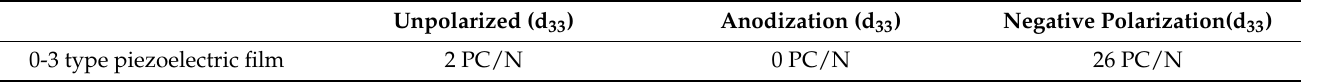
Table 3. Comparison of the piezoelectric properties of 0-3 type films after different polarization